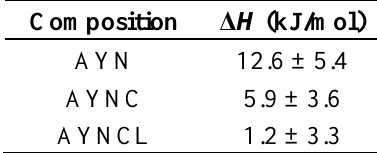
Table 2. Enthalpy changes of vaporization for ribbons of three